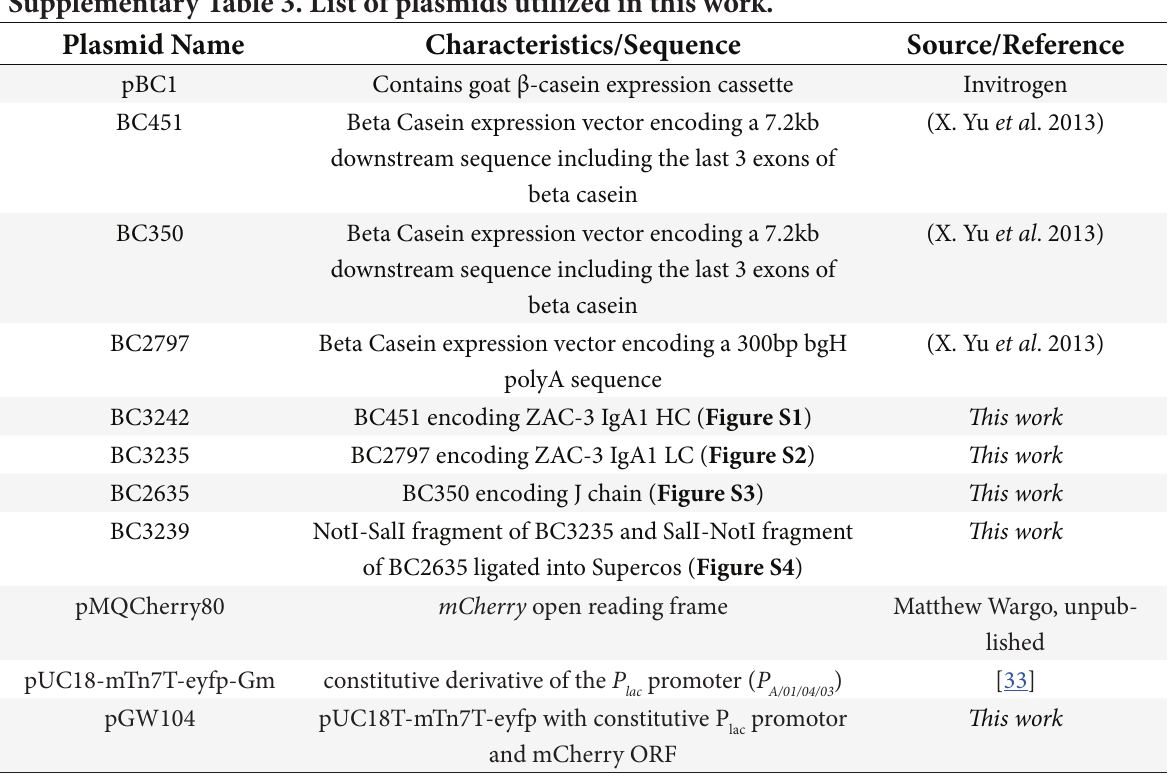
Supplementary Table 3. List of plasmids utilized in this